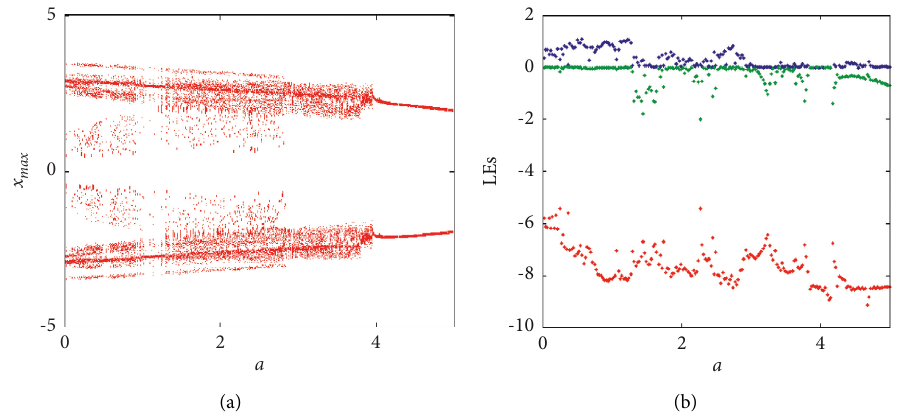
Figure 12: (a) The diagram of bifurcation. (b) Lyapunov exponents of system (4) when a ∈ ( 0 , 5 ) according to the other system parameter b � − 9, the incommensurate fractional order [ q